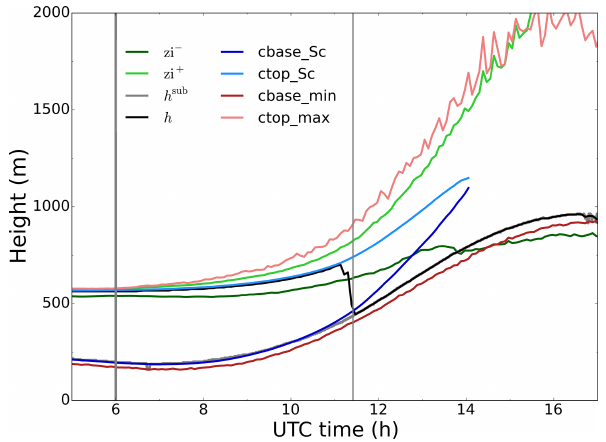
Figure 5. Time series of inversion layer top zi + (light green) and bottom zi − (dark green) heights, boundary layer height h (black) and subcloud buoyancy minimum height h sub (grey), stratocumu- lus cloud base cbase_Sc (dark blue) and top ctop_Sc (light blue) heights, and minimum cloud base cbase_min (dark red) and max- imum cloud top ctop_ max (light red) heights. Sunrise time and cloud breakup time are indicated by the thick and thin grey lines,